Question: Briefly state, in one sentence, what is plotted here.
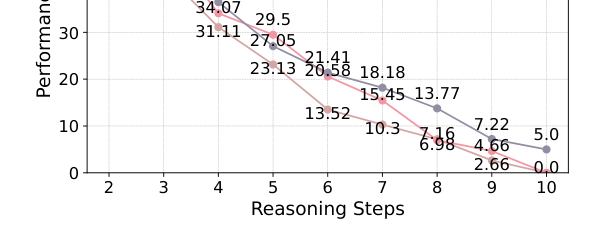
Answer: Comparative performance of advanced LMM and our method across increasing reasoning steps.